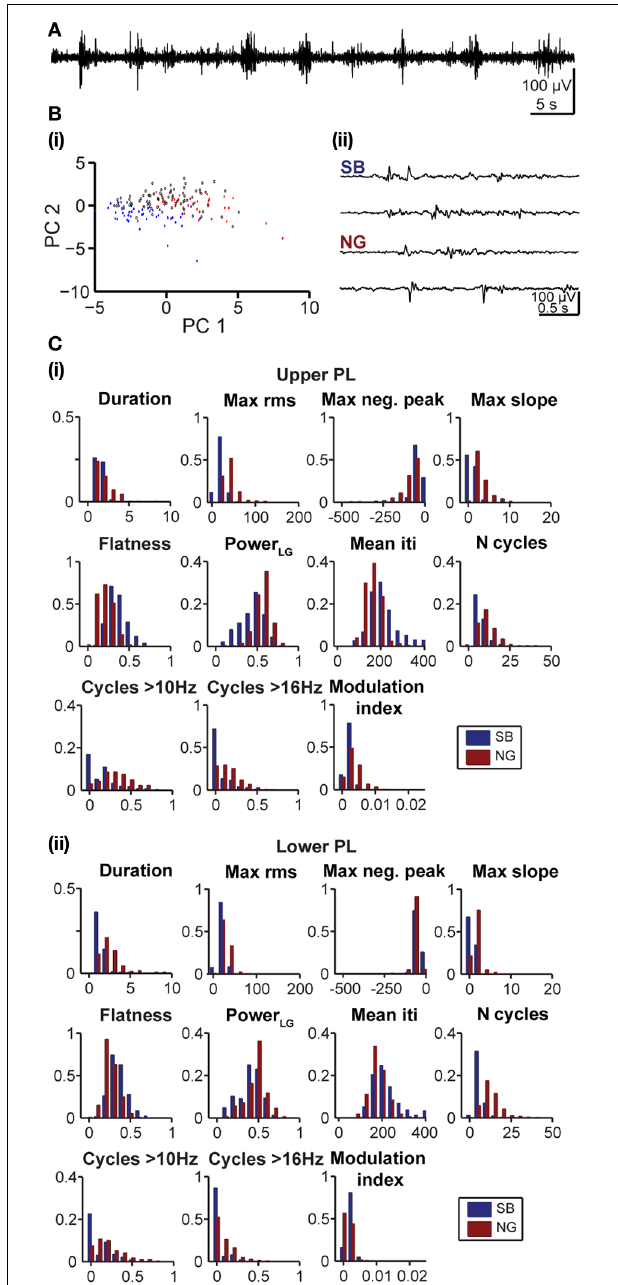
FIGURE 6 | Feature distribution of oscillatory events in the PL of pre-juvenile rats. (A) Extracellular LFP recording (4–100Hz) of the prefrontal oscillatory activity during the developmental switch from discontinuous to continuous pattern (P12 rat). (Bi) Automatic classification of oscillatory events in the PL of a P12 rat. Each dot corresponds to the projection of the feature vector of one event (SB in blue, NG in red, UC in white) into principal component space spanned by the first two principal components (PC1, PC2). (ii) LFP traces displaying examples of oscillatory events assigned by the unsupervised method as SB or NG. Note the similar appearance of the events that hampers their classification upon visual inspection. The signals were filtered between 4 and 100Hz. (C) Histograms displaying the distribution of values for distinct features of SB (blue bars) and NG (red bars) in the upper (i) and lower (ii) PL of pre-juvenile rats.